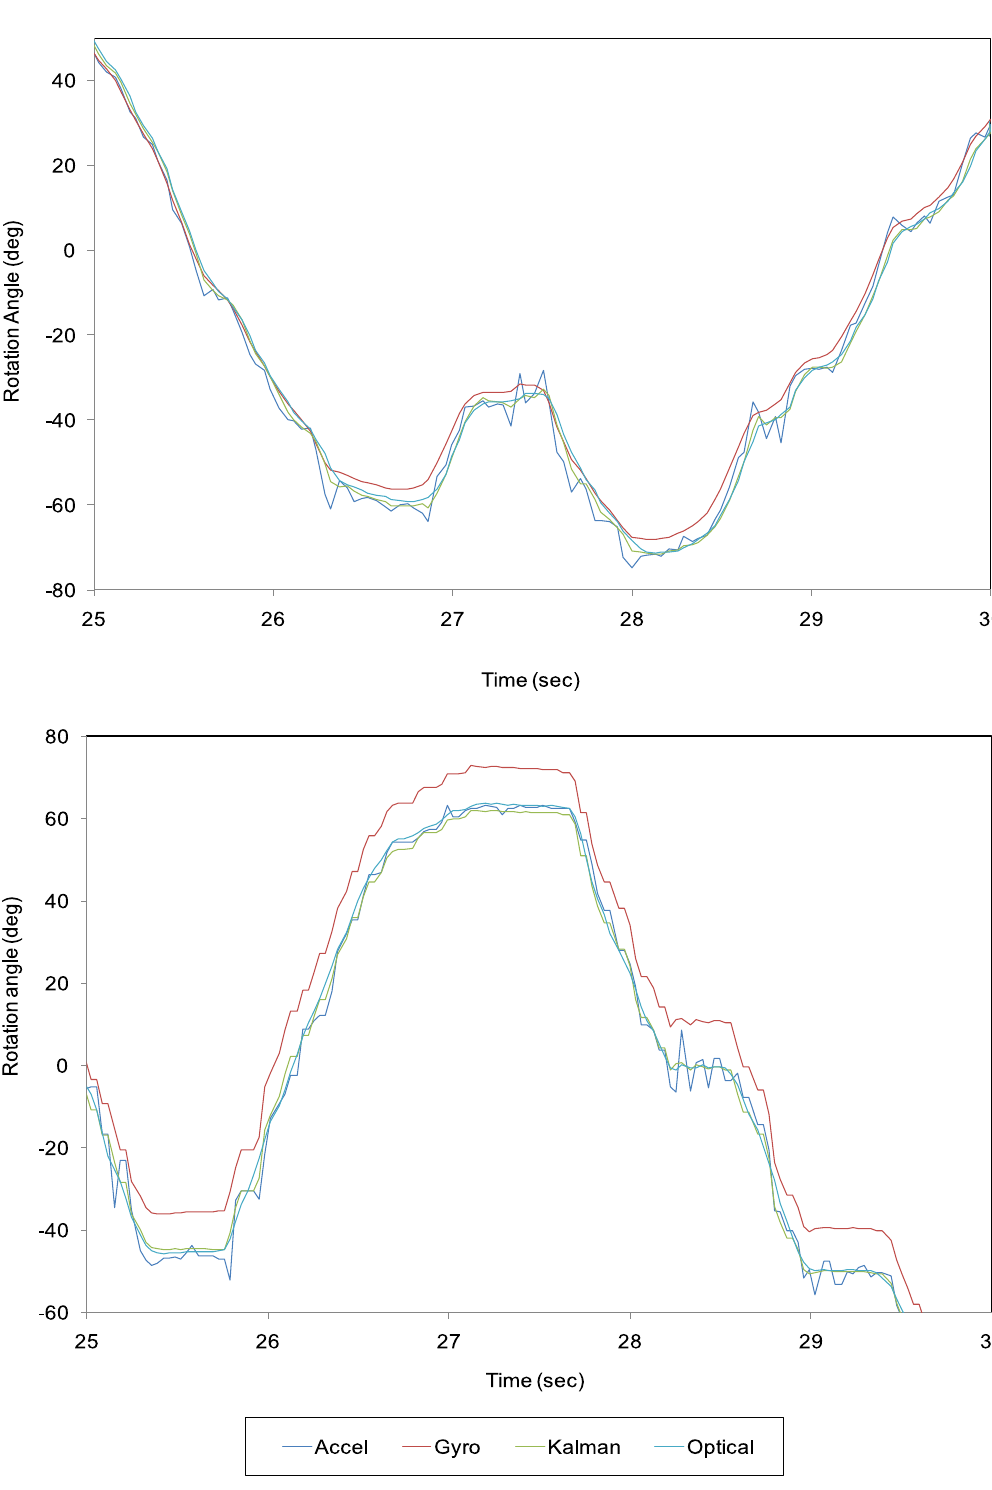
PLOS ONE | https://doi.org/10.1371/journal.pone.0186691 November3,